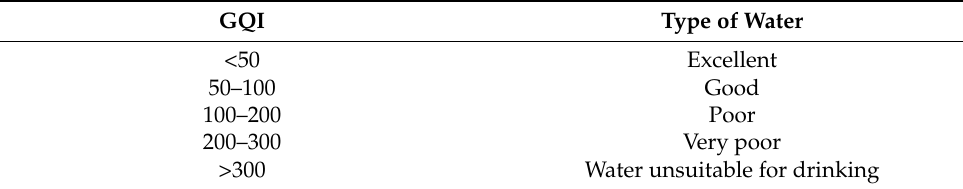
Table 3. Groundwater quality classifications for drinking based on GQI